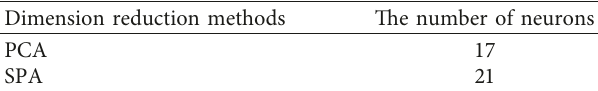
Table 3: The optimal number of neurons in the hidden layer of BPNN models.